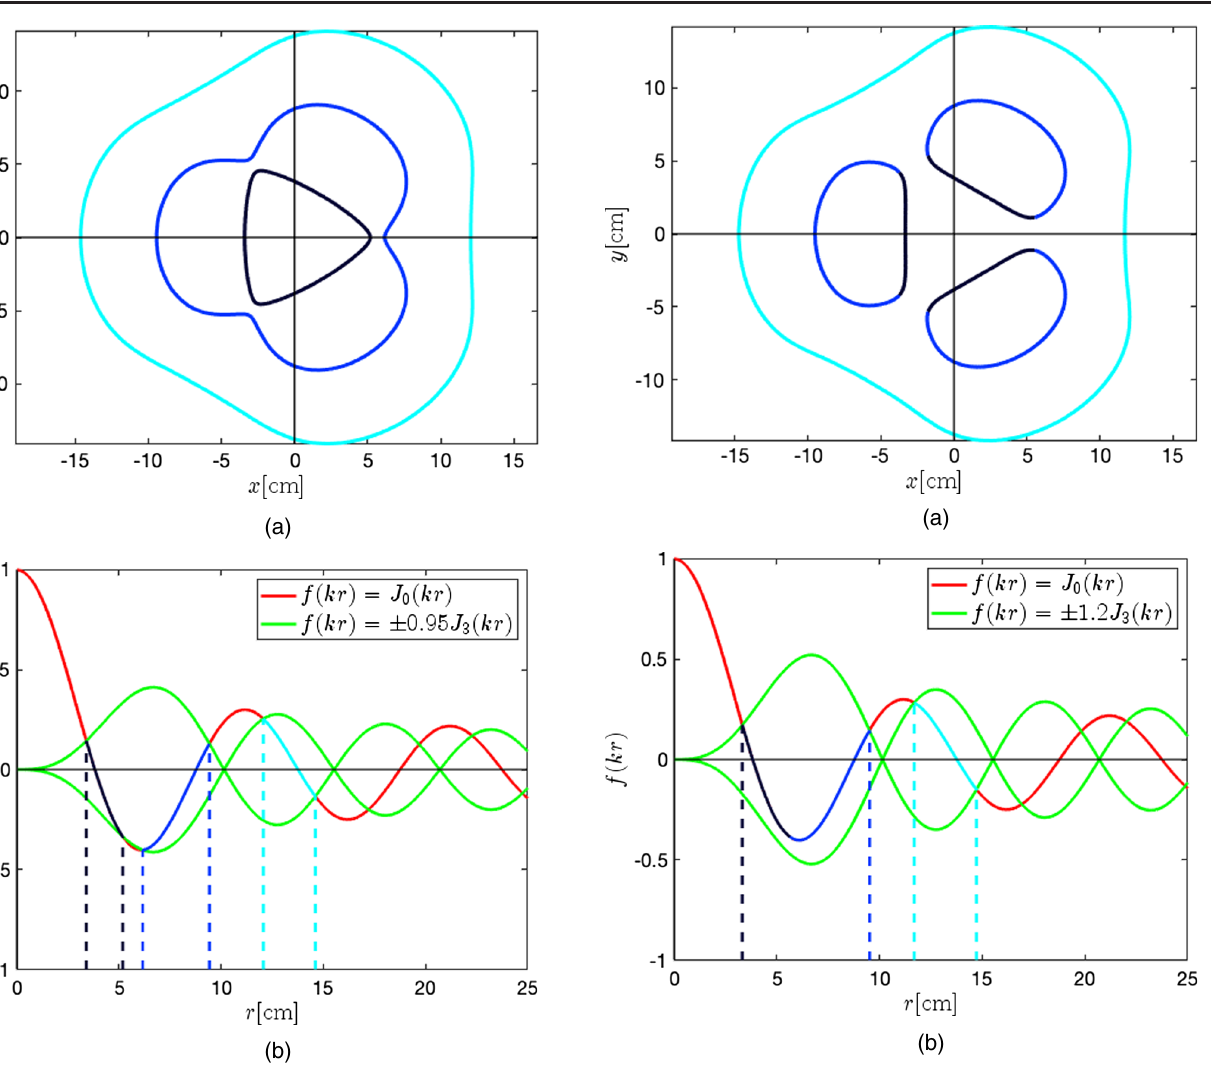
FIG. 2. 3 GHz TM modes with ˜ g 3 = ˜ g 0 ¼ 0 . 95 and ϕ 3 ¼ 0 . f 0 ; 3 g η 0 η Þ θ Þ , that support the η ¼ 1 , 2, and 3 (a) The cavity shapes, r ð 0 ð TM modes as black, blue, and cyan lines respectively. f 0 ; 3 g η 0 (b) J 0 ð kr Þ and − 0 . 95 J 3 ð kr Þ cos 3 θ plotted against r for θ ¼ 0 , π = 3 . The η ¼ 1 , 2, and 3 solutions where the two functions intersect for all θ are plotted as black, blue, and cyan lines.